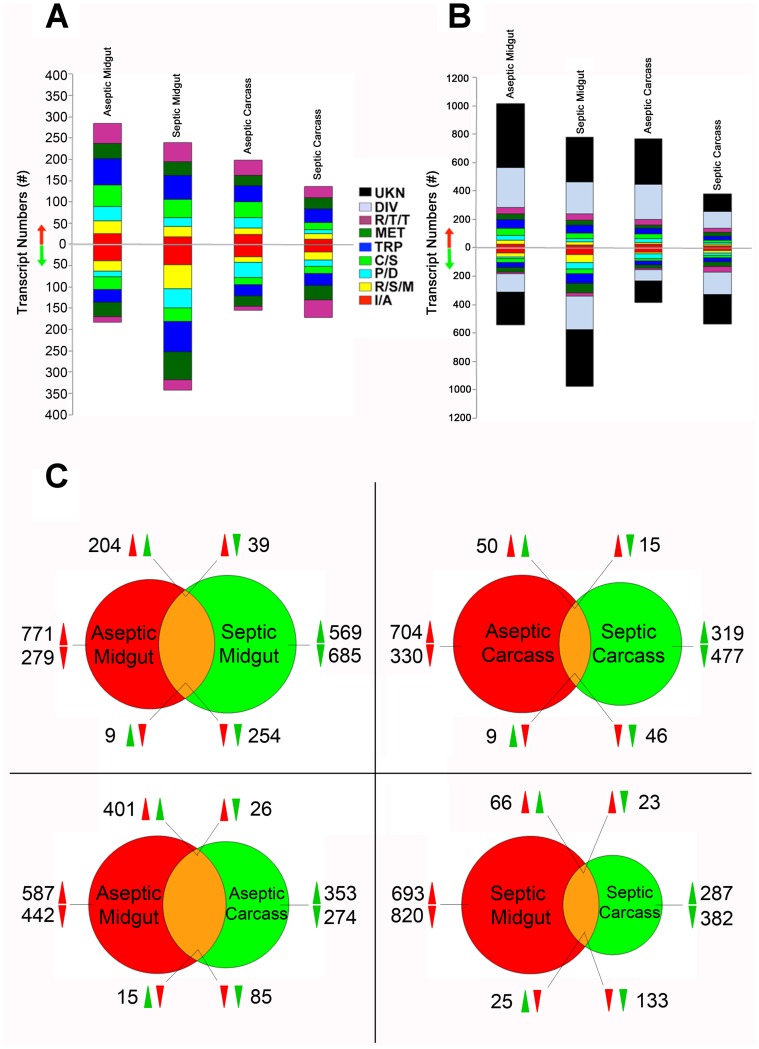
Global gene regulation of mosquitoes at 24 h post-P. falciparum infection under septic and aseptic conditions.(A) Numbers of up- or down-regulated genes in distinct functional groups according to tissue (midgut/carcass) and treatment (septic/aseptic) at 24 h post-P. falciparum infection (not including DIV/UKN). (B) Same as in (A) but including DIV/UKN. (C) Venn diagrams comparing the total numbers of regulated genes between tissues and treatments. Red arrows correspond to the tissues/treatments in the left circles, and green arrows correspond to the tissues/treatments in the right circles. The arrow direction indicates up- or down-regulation. I/A: putative immunity and apoptosis; R/S/M: oxidoreductive, stress-related and mitochondrial; C/S: cytoskeletal, structural; MET: metabolism; R/T/T: replication, transcription, translation; P/D: proteolysis, digestion; TRP: transport; DIV: diverse; UKN: unknown functions.